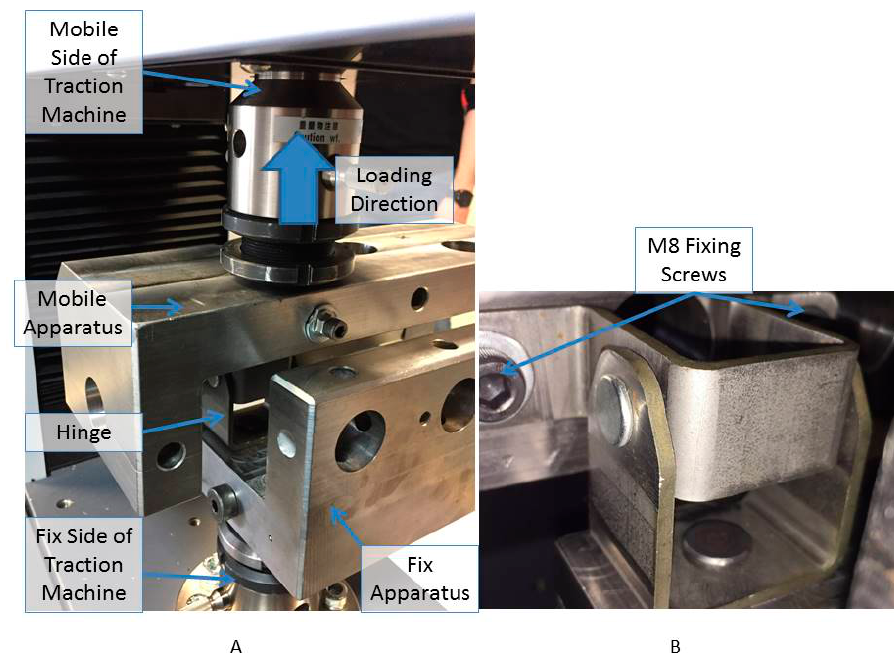
Figure 17. UNECE 11 test configurations (( A ) test setup, ( B ) hinge appearance on test setup).